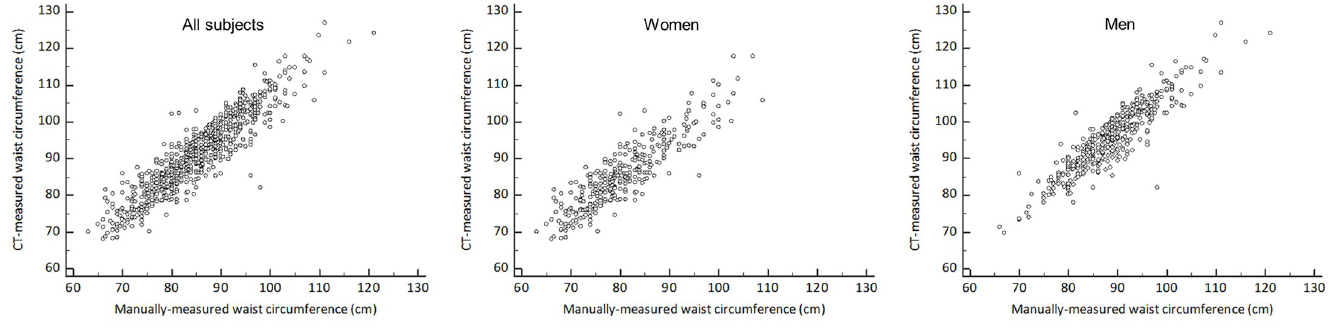
Fig 2. Scatter plots of CT-measured and manually-measured waist circumferences.